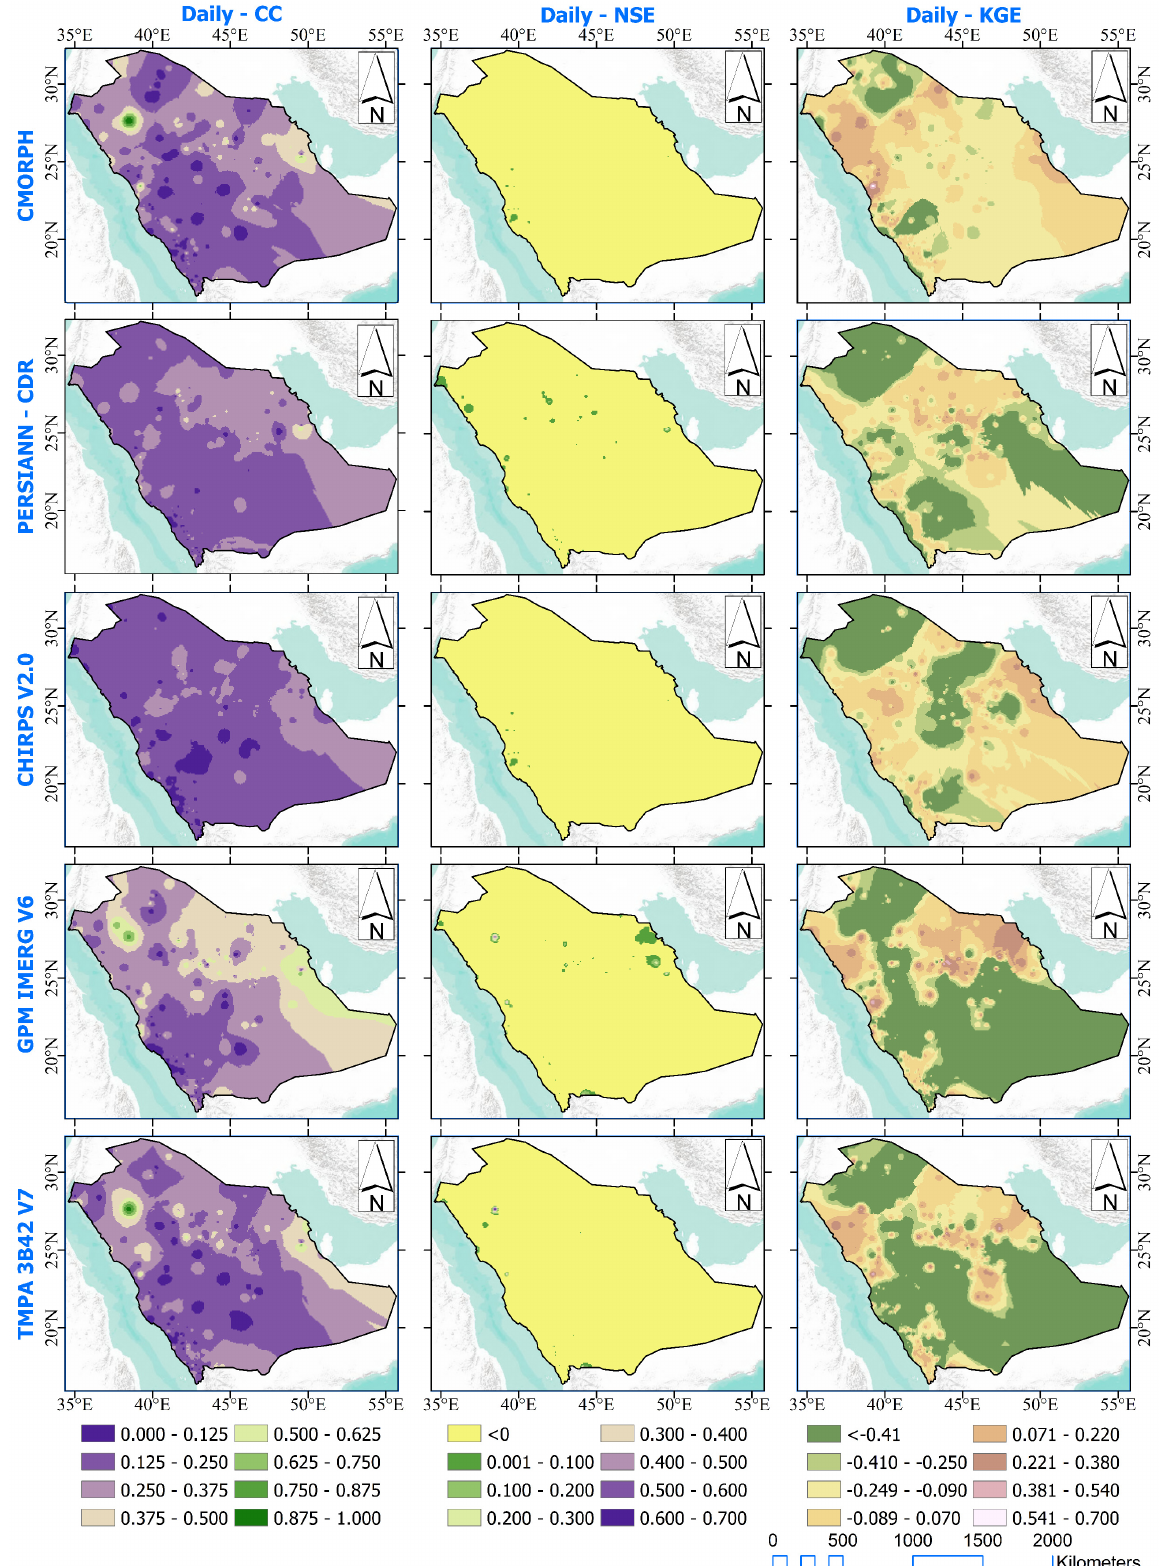
Figure 8. Spatial distribution of daily statistical quantitative metrics (CC, NSE, and KGE) over the study area.